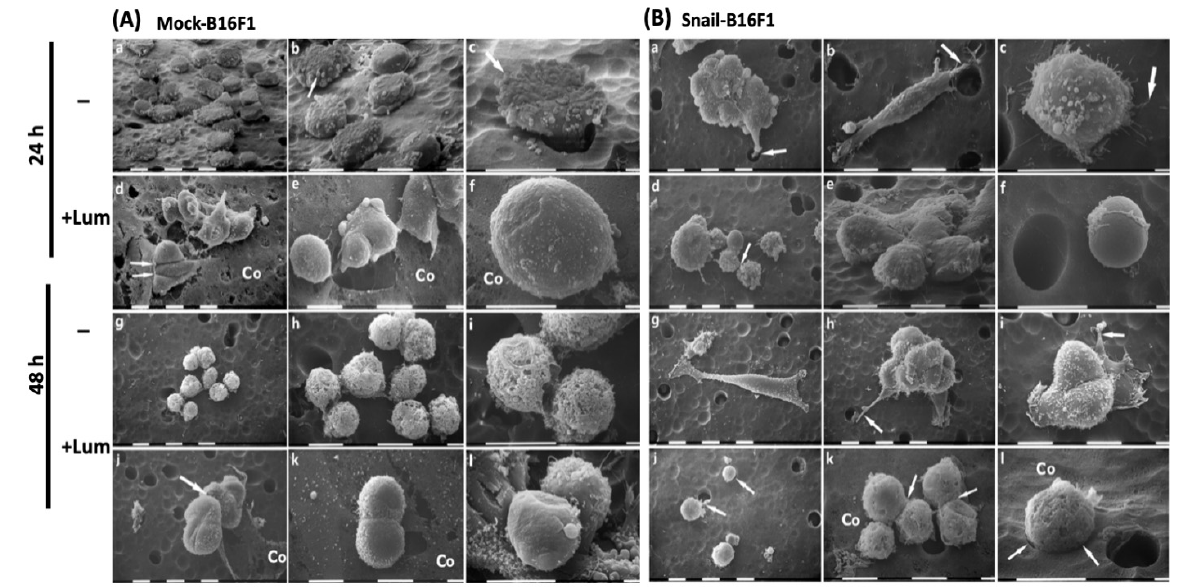
Figure 3. SEM of Mock-B16F1 and Snail-B16F1 melanoma cells melanoma cells cultured in serum-free conditions on a Millipore TM membrane-filter and coated with type I collagen before and after treatment with lumican for 24 and 48 h. ( A ) Untreated Mock-B16F1 melanoma cells, cultured for 24 h (images ( a – c )). A “funnel” shaped cell with microvesicles (arrow) and crossing a Millipore pore is shown in image c. Cells treated with lumican (100 nM) are shown in images ( d – f ). They assemble in small groups, with tight cell–cell contacts (arrows) (Co indicates the collagen coating). Untreated Mock-B16F1 cells cultured for 48 h are given in images ( g – i ). Following treatment with lumican for 48 h, Mock-B16F1 cells exhibiting tight cell–cell contacts and appear more grouped (images ( j – l )). The globular cell on the left side appears almost completely smooth, free of any membrane protrusions (image ( l )). ( B ) Untreated Snail-B16F1 melanoma cells cultured for 24 h (images ( a – c )). Cells are involved in collective invasion with the leader cell developing an invadopodia (arrow) (image ( a )). A mesenchymal or morphological elongated cell invades following an individual invasion process (image ( b )). A globular cell displaying microvesicles shows relatively long microvilli (arrow), which anchors to type I collagen coating (image ( c )). Snail-B16F1 melanoma cells treated with lumican for 24 h are shown in images ( d – e ). A single globular cell shows a completely smooth surface with no cytoplasmic protrusions like microvilli or microvesicles (image ( f )). Untreated Snail-B16F1 cells are shown in images ( g – i ). A mesenchymal-elongated cell showing lamellipodia is visible in image g. In the collective invasion process, the leader cell developing invadopodia (arrow) and the following grouped cells are in tight contact to each other and exhibit microvilli on their surface (images ( h – i )). Snail-B16F1 cells treated for 48 h with lumican are shown in images ( j – l ). They appeared as both isolated (arrows) (image ( j )) and grouped globular cells showing both cell-cell contacts (arrows) and relatively smooth cytoplasmic surfaces with no evident microvesicles (image ( k )). A single globular cell is penetrating a membrane-filter pore (arrows) by an amoeboid movement with no deformation of the original globular shape (images ( l )). All images were taken from the top of the Millipore filter so that cells are passing through or preparing to cross the barrier. White bars = 10 μ m. Three different samples were used for every experiment.